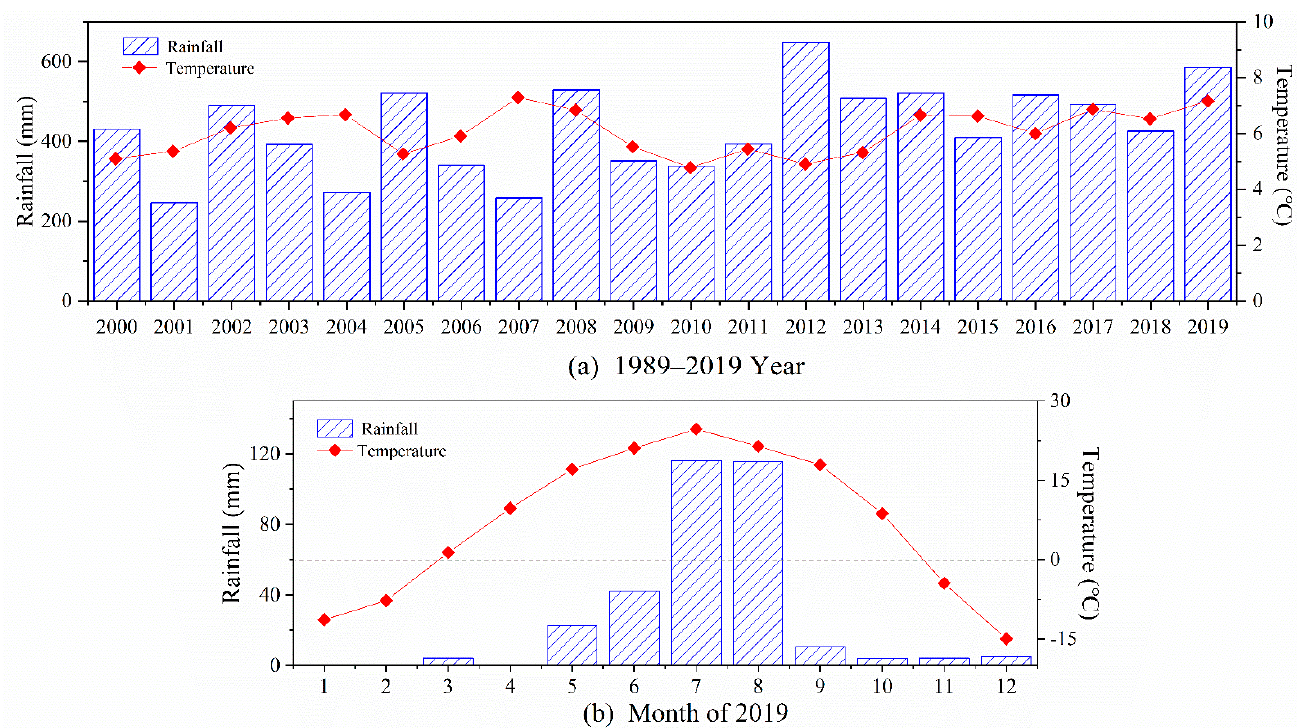
Figure 2. Temperature and precipitation in Chagan Lake Catchment. ( a ) Temperature and precipitation from 2000 to 2019. ( b ) Temperature and precipitation in 2019.